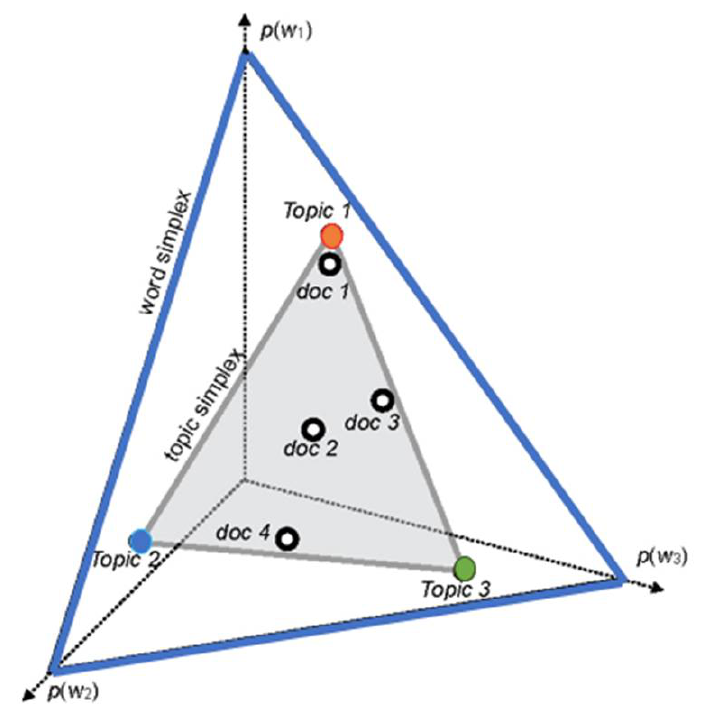
Figure 1. Geometric interpretation of LDA as a (V-1)-dimensional word simplex with V = w1, w2 and w3, with each point representing a discrete distribution of word probabilities. A point that is closer to one of the corners implies that the word has a higher probability mass. (Adapted from [18]).